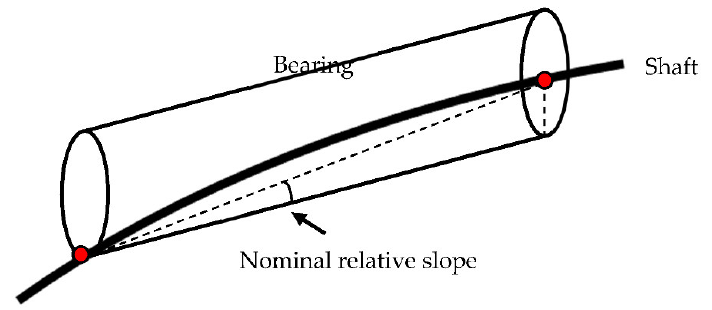
Figure 14. Stern tube bearing relative slope angle.